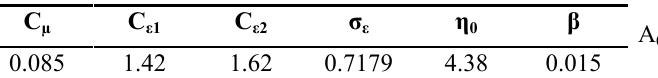
Table 2. Constant values of RNG k – ε model